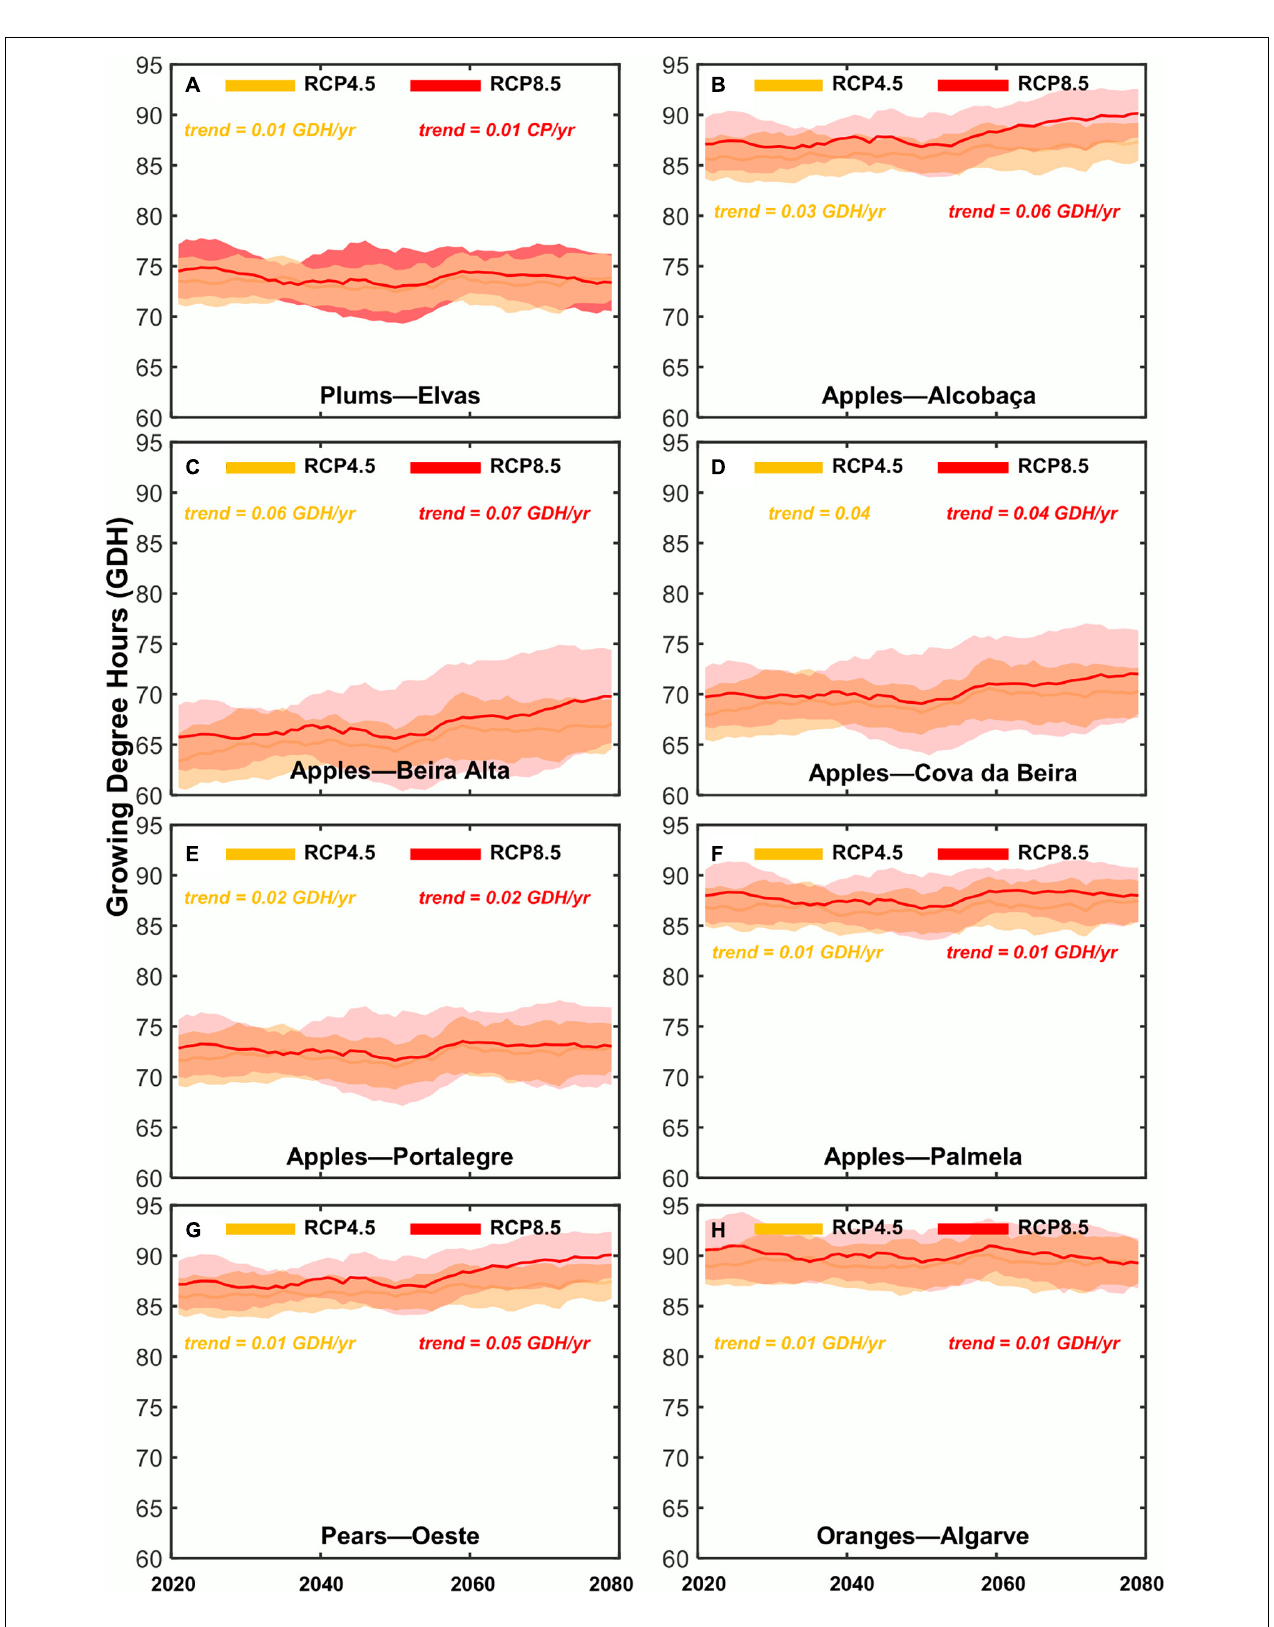
FIGURE 5 | Same as Figure 4 but for the Growing Degree Hour (GDH) index. Values are shown in × 10 3 .